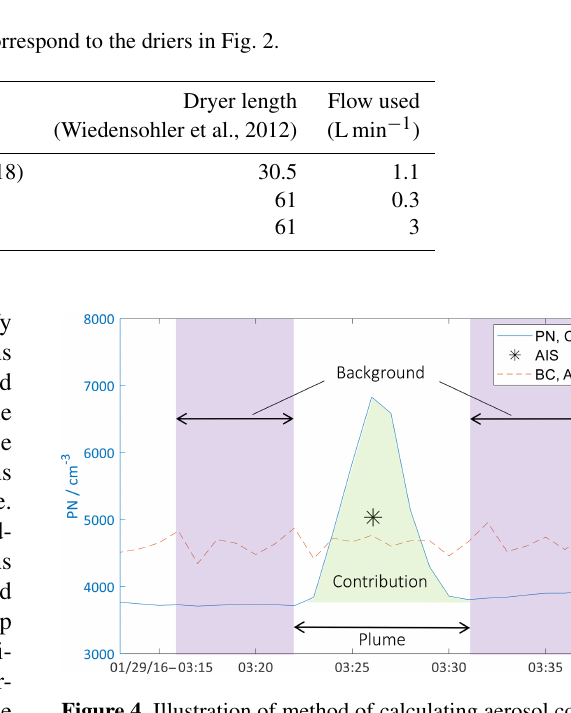
Figure 4. Illustration of method of calculating aerosol contribution of individual ship plumes. Particle number concentration measured by a CPC (solid blue) and black carbon measured by an Aethalome- ter (AE33, dashed orange) during ca. 25min of ambient sampling, and calculated time of arrival of the aerosol plume based on AIS and wind data (star). Plume duration is estimated by observation, and background concentrations are based on 6min plus 6min of adjacent data. The average of the background is subtracted from the plume concentrations to obtain only ship emission